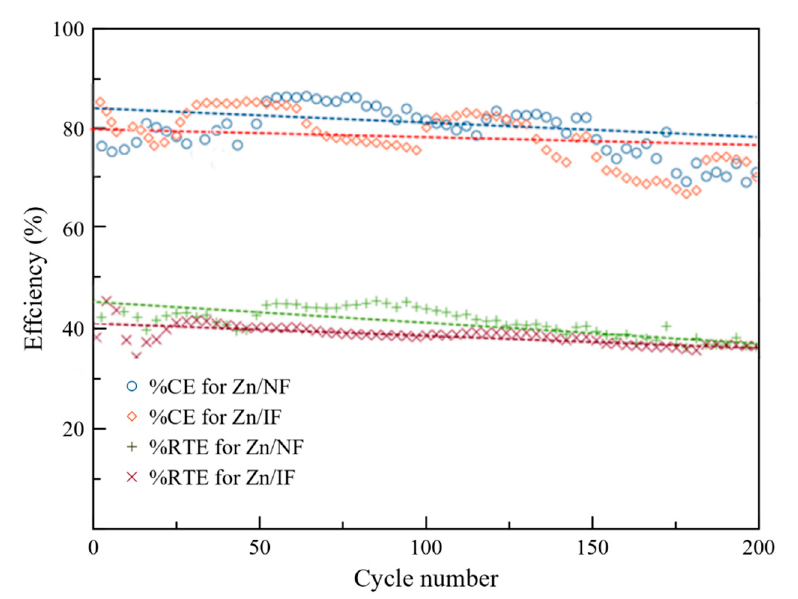
Figure 9. The coulombic efficiency (CE) and round-trip efficiency (RTE) of electrostatic charge/discharge performance of a ZAB with Zn/IF and Zn/NF anodes within 200 cycles.